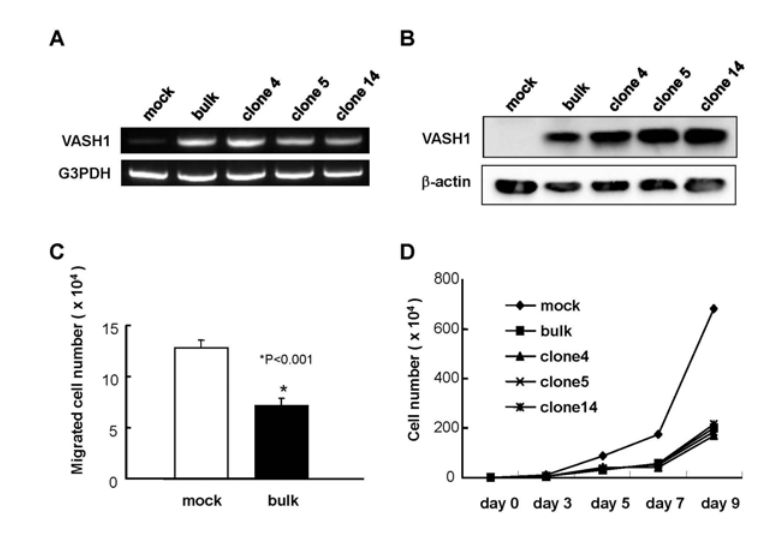
Figure 1. Establishment of VASH1 overexpressing MS1